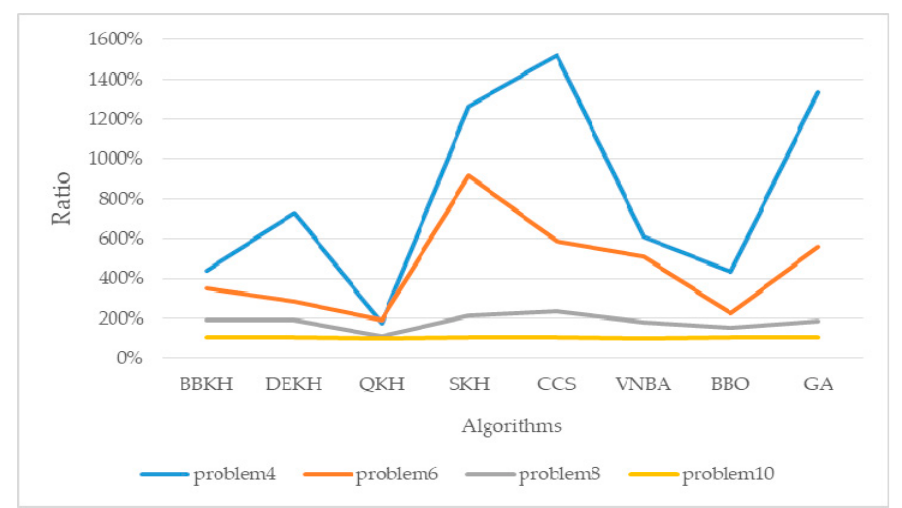
Figure 15. Ratio of AKQPSO over other algorithms in the third group.